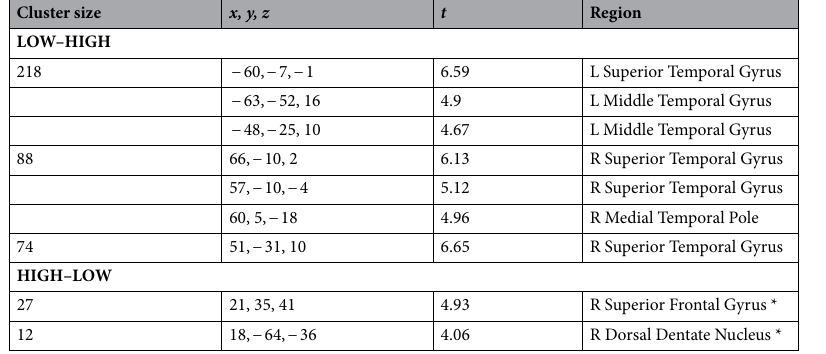
Table 2. Rating effects. Results of LOW – HIGH contrast and HIGH – LOW contrast. Contrasts were significant at a voxel-level threshold of p < .001 combined with an FWE correction of p < .05 for cluster size. MNI coordinates and t -scores are from the peak voxels of a cluster. * Contrasts were significant at a peak voxel threshold of p < .005 (uncorrected), with no cluster thresholding.